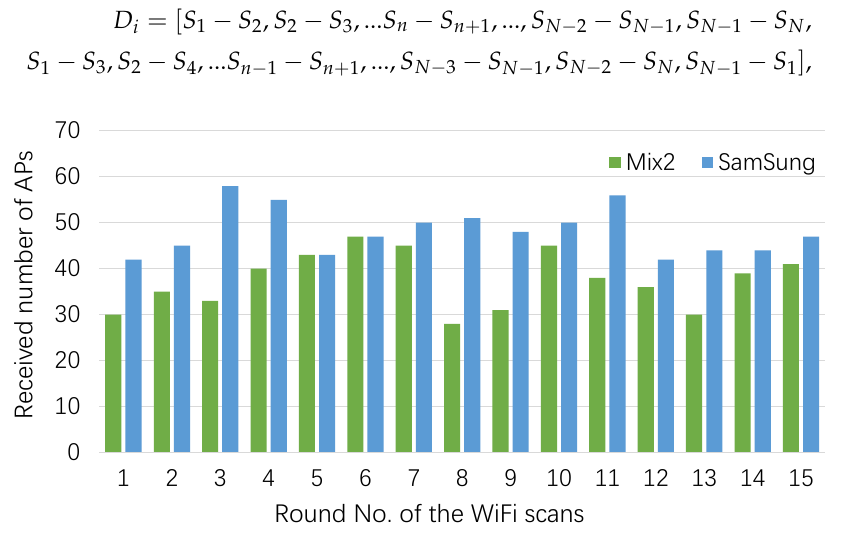
Figure 4. Number of APs detected for each round of Wi-Fi scans in terms of Mix2 and the Samsung S8. Here, 15 rounds of scans are summarized, and it is noted that Mix2 is a brand of smartphone produced by Xiaomi in